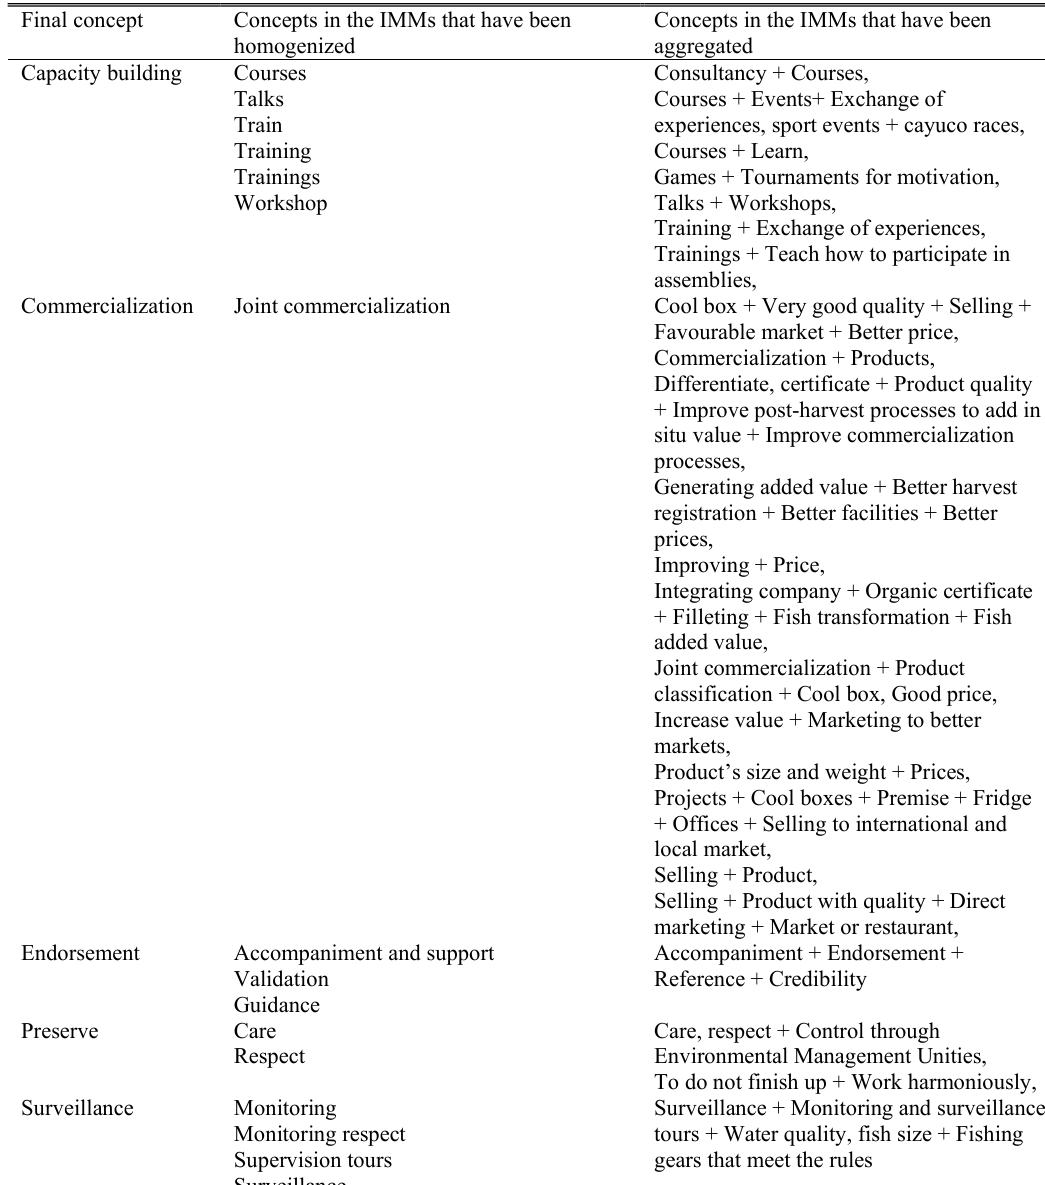
Table A2.3. Qualitative aggregation of actions Final